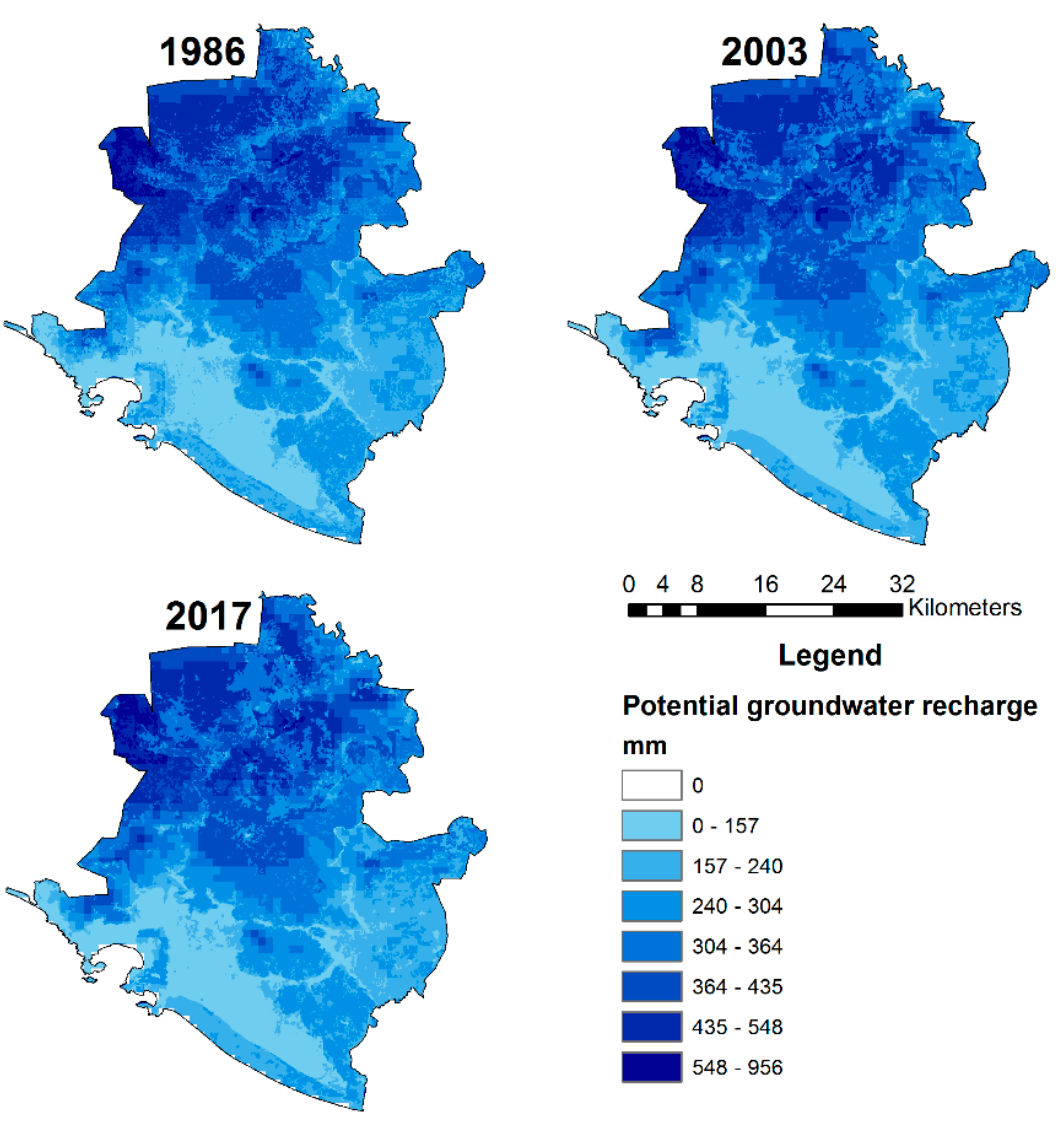
Figure 6. PGR depth 1986–2017.